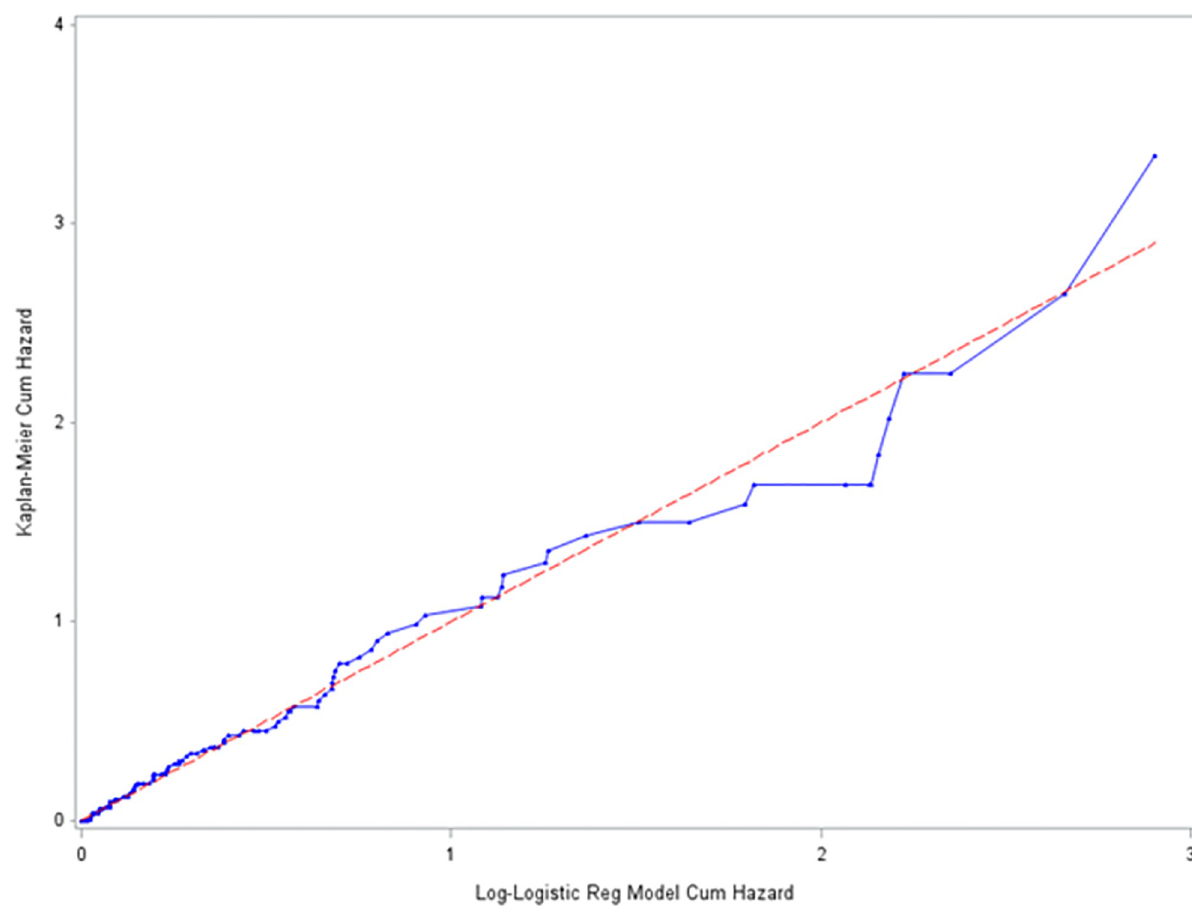
Fig 6. Estimated cumulative hazard plot of the Cox-Snell residuals for the log-logistic baseline distribution, LPAC, 2015–2019.